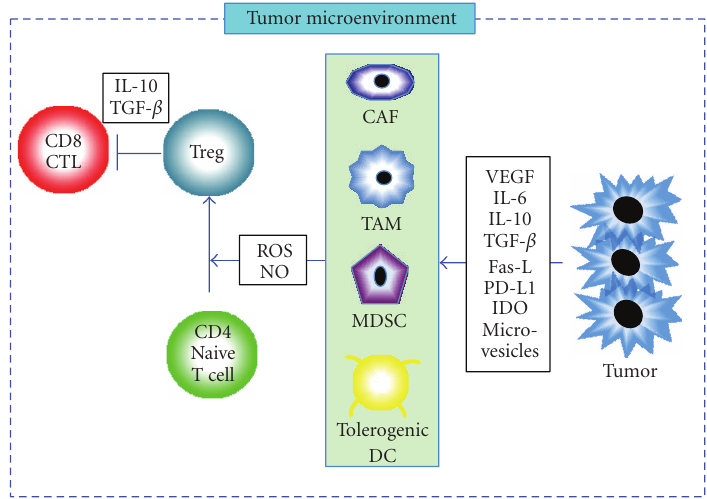
Figure 2: Immune suppressive responses at the tumor microenvironment. Tumor cells secrete various factors such as VEGF, IL-6, IL-10, TGF- β , Fas-L, IDO, PD-L1, and microvesicles, all of which promote the accumulation of heterogeneous populations of tumor-associated macrophage (TAM), myeloid-derived suppressor cell (MDSC), or tolerogenic DC. These immunosuppressive cells inhibit antitumor immunity by various mechanisms, including elaboration of reactive oxygen species (ROS) and nitrogen oxide (NO). The tumor microenvironment also promote the accumulation of regulatory T cell (Treg) that suppresses CD8+ CTL function through secretion of IL-10 or TGF- β from Tregs and tumor cells.